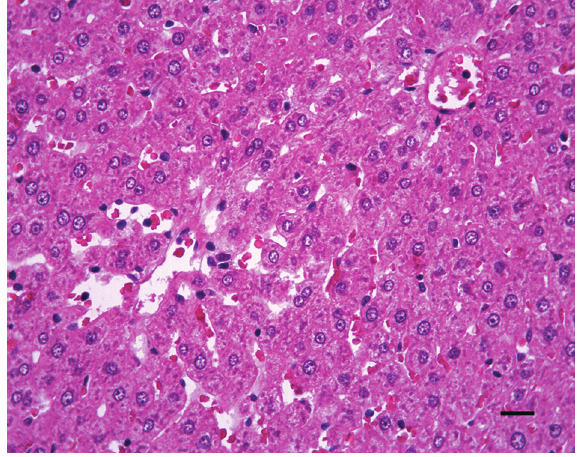
Figure 3. Liver specimen from the cerulein + pentoxifylline-treat- ed group. A small area of cell infiltration in the portal area is evi - dent. H-E, 40X (bar = 20 µm).